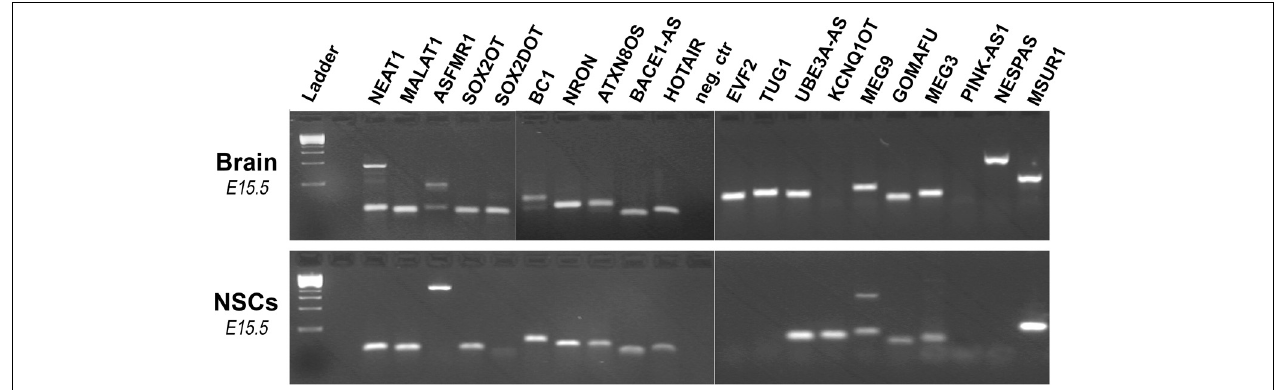
FIGURE 2 | RT-PCR-based detection of various lncRNAs associated with CNS-related diseases or disorders. Experiments were performed using cDNA samples derived from embryonic mouse brain ( E15.5 ) or NSCs isolated